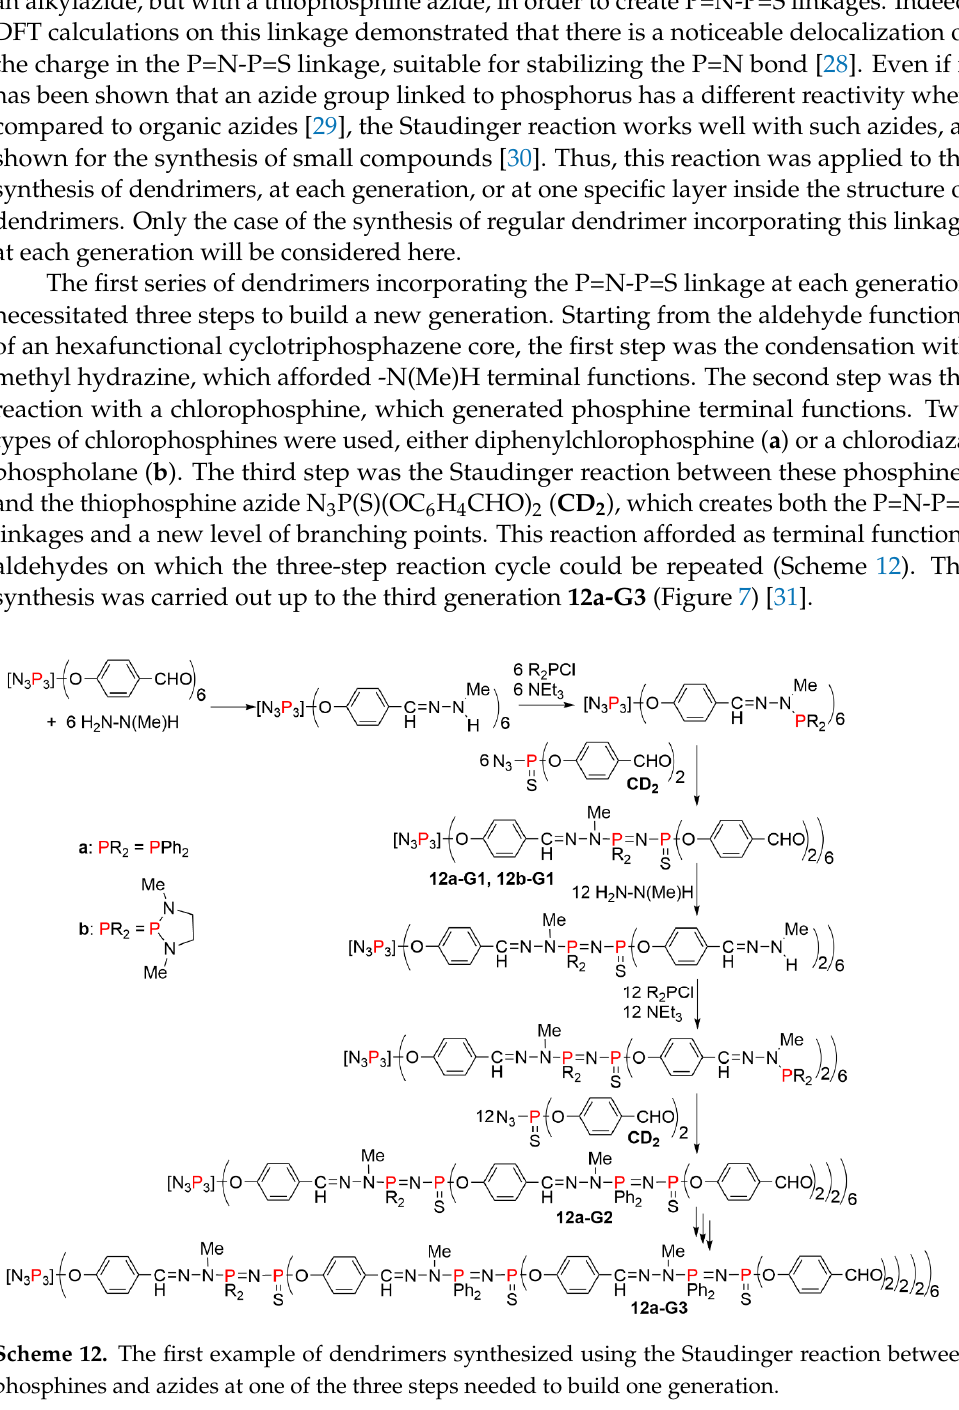
phosphines and azides at one of the three steps needed to build one